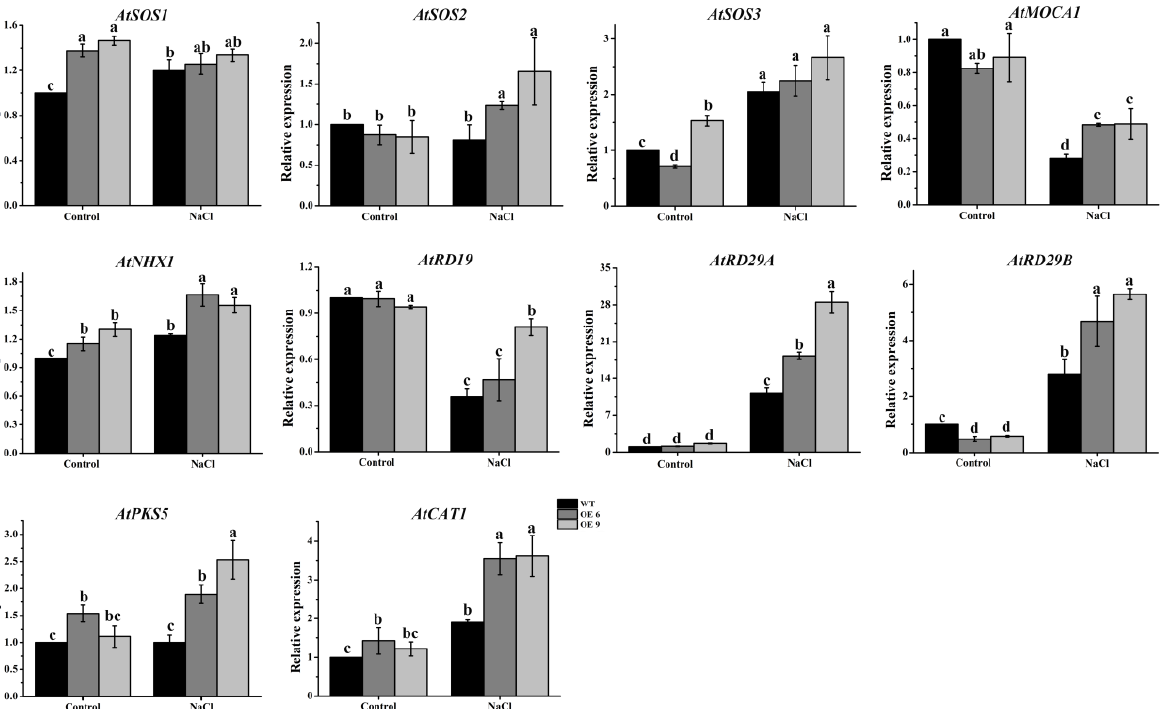
Figure 10. Effects of NaCl on the expression patterns of multiple salt responsive genes in Arabidopsis transgenic plants overexpressing TaTIP4;1. Fifteen-day-old WT, OE6 and OE9 seedlings were treated with or without 200 mM NaCl for 6 h. Gene expression was evaluated by qRT-PCR method, AtActin2 was used as the internal control. Values are mean ± SD (n ≥ 3). Diverse lowercase letters above the error bars reveal remarkable differences in the values among the seedlings by one way ANOVA and Tukey’s HSD test ( p < 0.05).